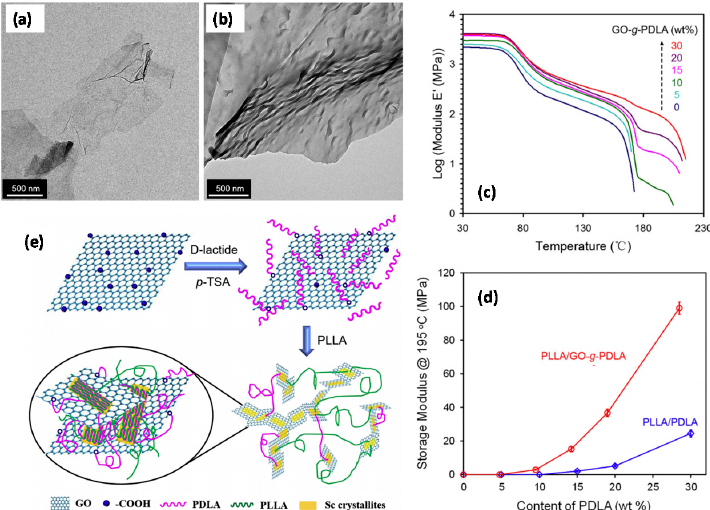
Figure 21. TEM images of ( a ) GO and ( b ) purified GO- g -PDLA. Temperature dependency of storage modulus ( E ’) for PLLA mixed with various concentrations of ( c ) GO- g -PDLA. ( d ) Variation in storage modulus at 195 °C as a function of the PDLA content for PLLA/PDLA and PLLA/GO- g -PDLA mixtures, respectively. ( e ) Schematic showing the synthesis of GO-g-PDLA by the direct melt-polycondensation approach and the formation of GO enhanced stereocomplex (Sc) network. p-TSA stands for p-toluenesulfonic acid [79].